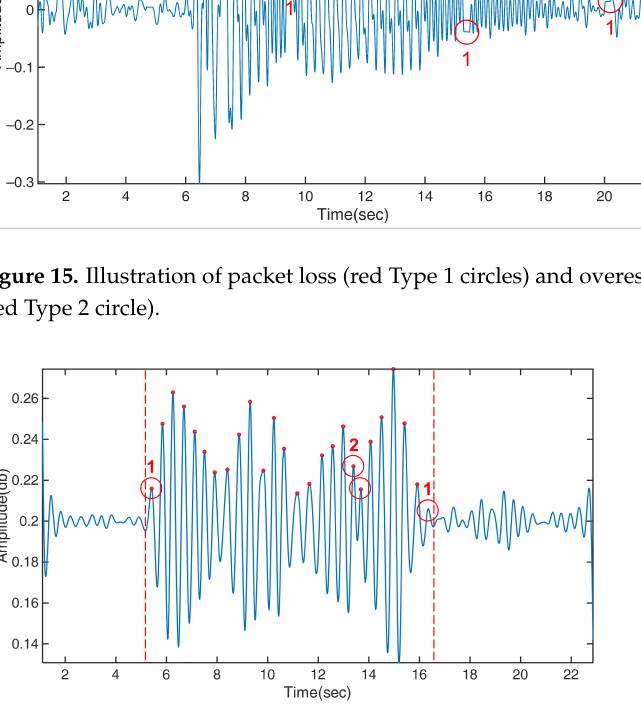
Figure 16. Illustration of two types of errors: slow response (Type 1 circles) and two peaks in the same half wave (Type 2 circles). The smaller red circles indicate peaks in the data identified by our algorithm and are used to count the number of